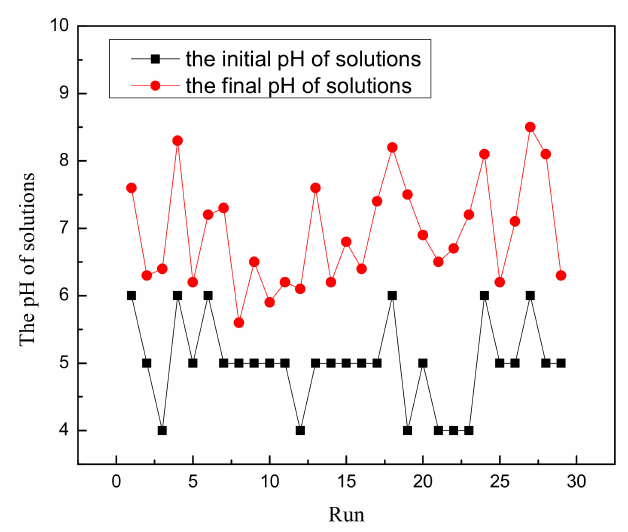
Figure 11. The difference between the initial and final pH of the